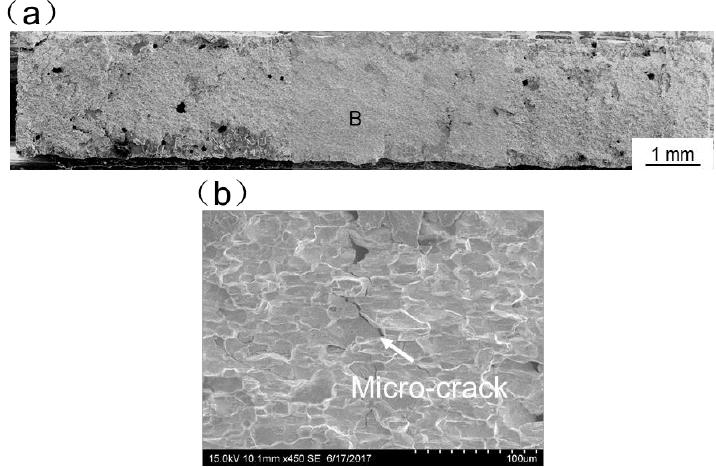
Figure 14. SEM images of tensile fracture when the offset is 0 mm (( a ) Overall morphology; ( b ) Magnified images of region B in panel ( a )).